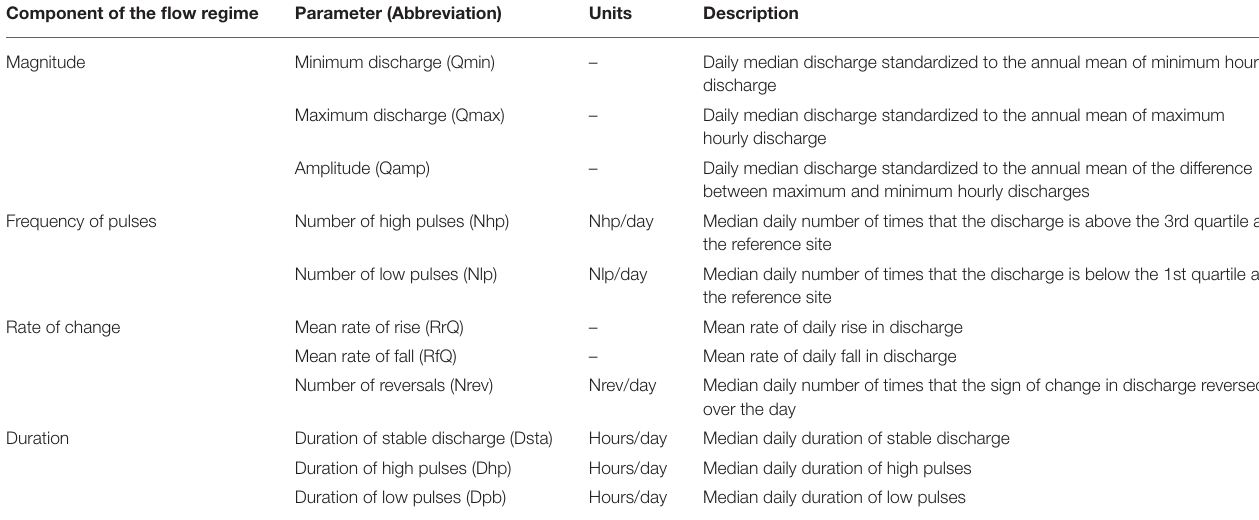
TABLE 2 | Indicators of hydrological alteration at the sub-daily